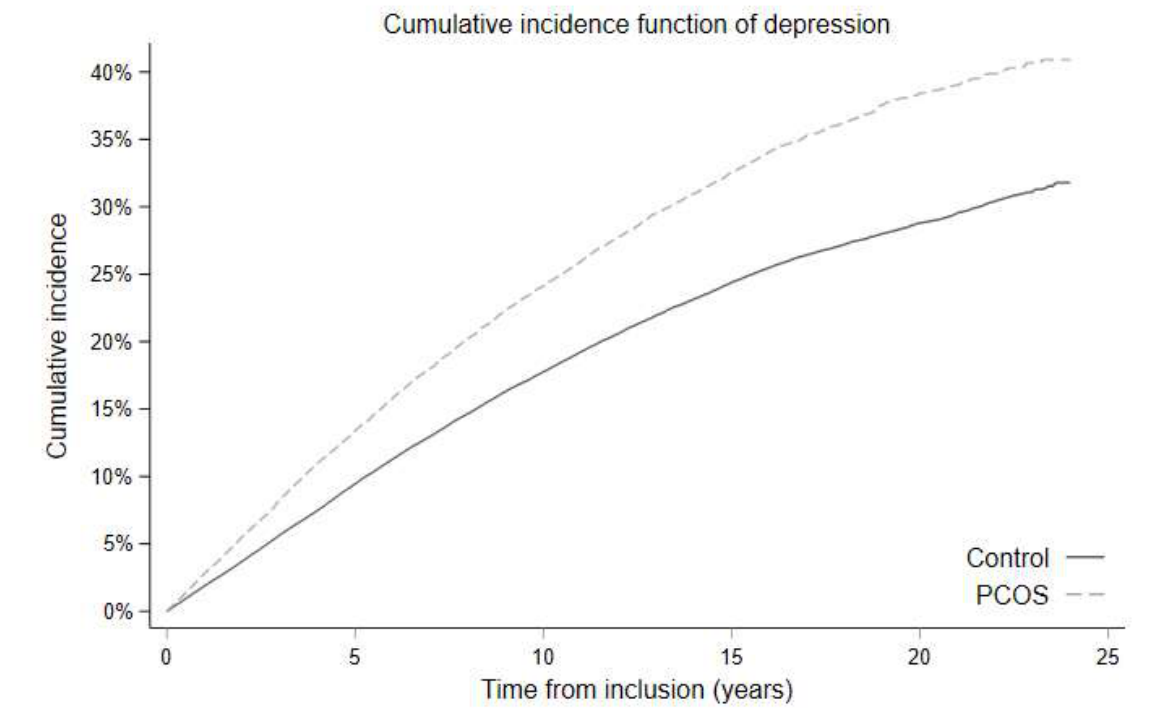
Figure 2. Cumulative incidence of depression in women with PCOS and controls in PCOS Denmark. Table 2. Risk of development of depression in PCOS OUH, PCOS Denmark and controls after the